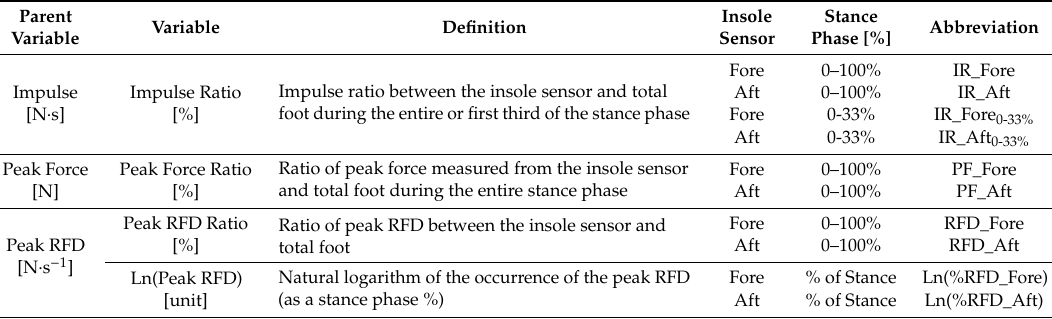
Table 1. Ten variables calculated from the Loadsol TM insole measurements are defined with respect to the sensor used and the percentage of the stance phase used in calculation.